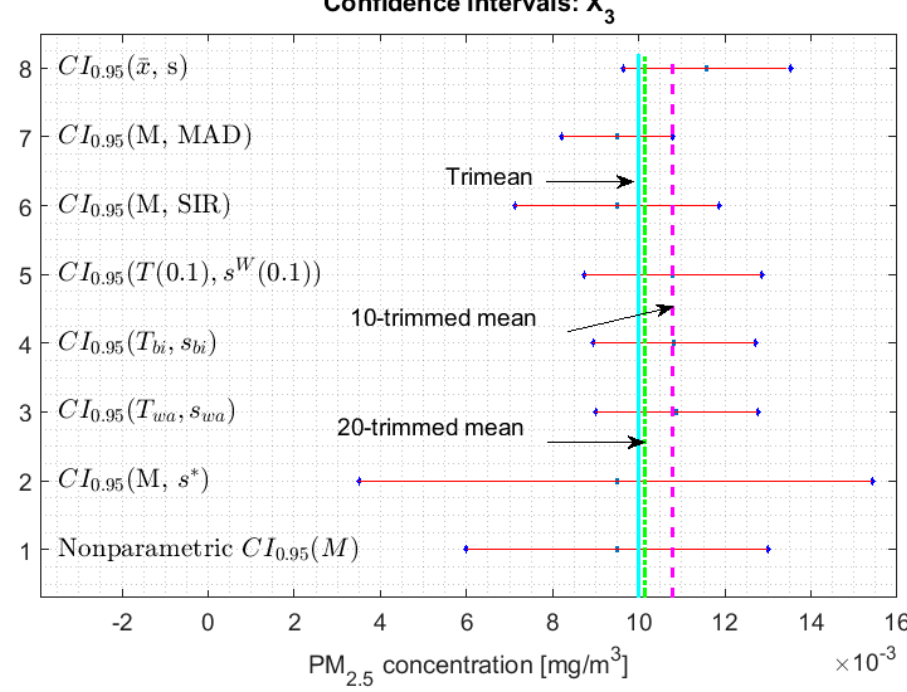
Sensors 2020 , 20 , 654 Figure 4. 95% confidence intervals (𝐶𝐼 (cid:2868).(cid:2877)(cid:2873) ) for robust and non-robust estimators: 𝑋 (cid:2871) . Figure 4. 95% confidence intervals ( CI 0.95 ) for robust and non-robust estimators: X 3 .